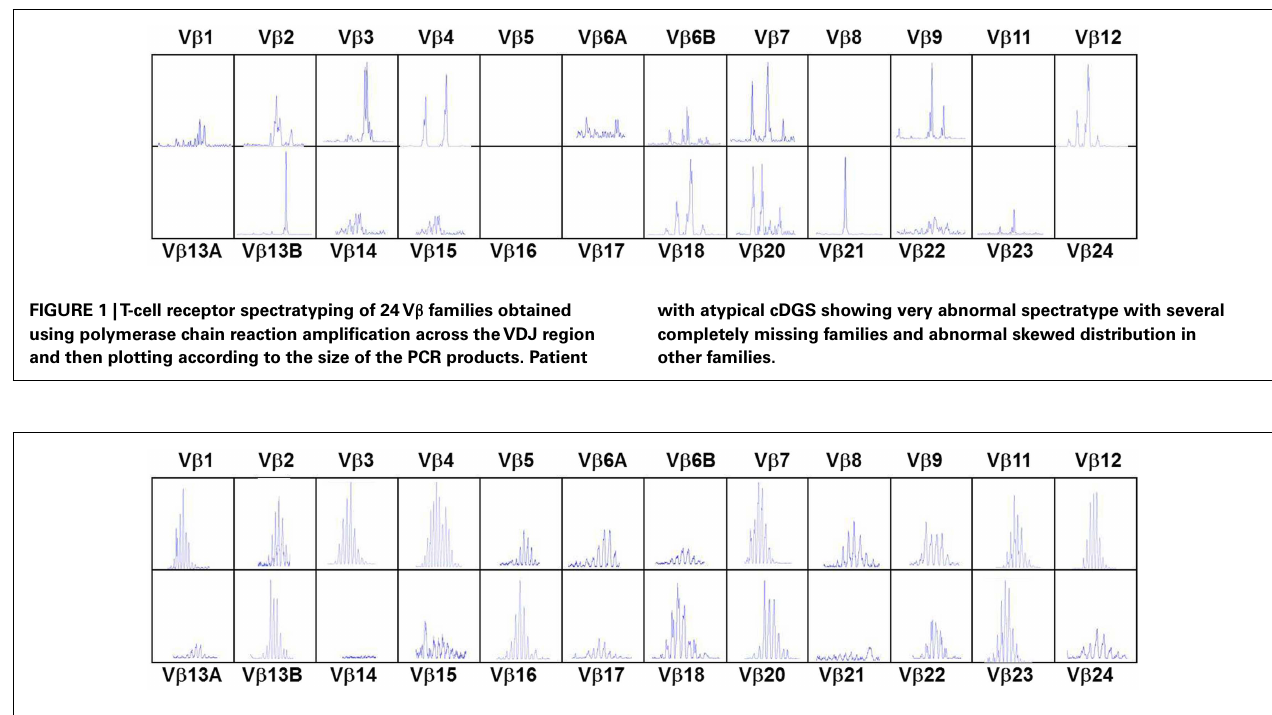
FIGURE 2 |T-cell receptor spectratyping performed as in legend to Figure 1. Same patient as in Figure 1, 23months after thymus transplantation. Much more normal spectratype.All families represented mostly with Gaussian distribution.